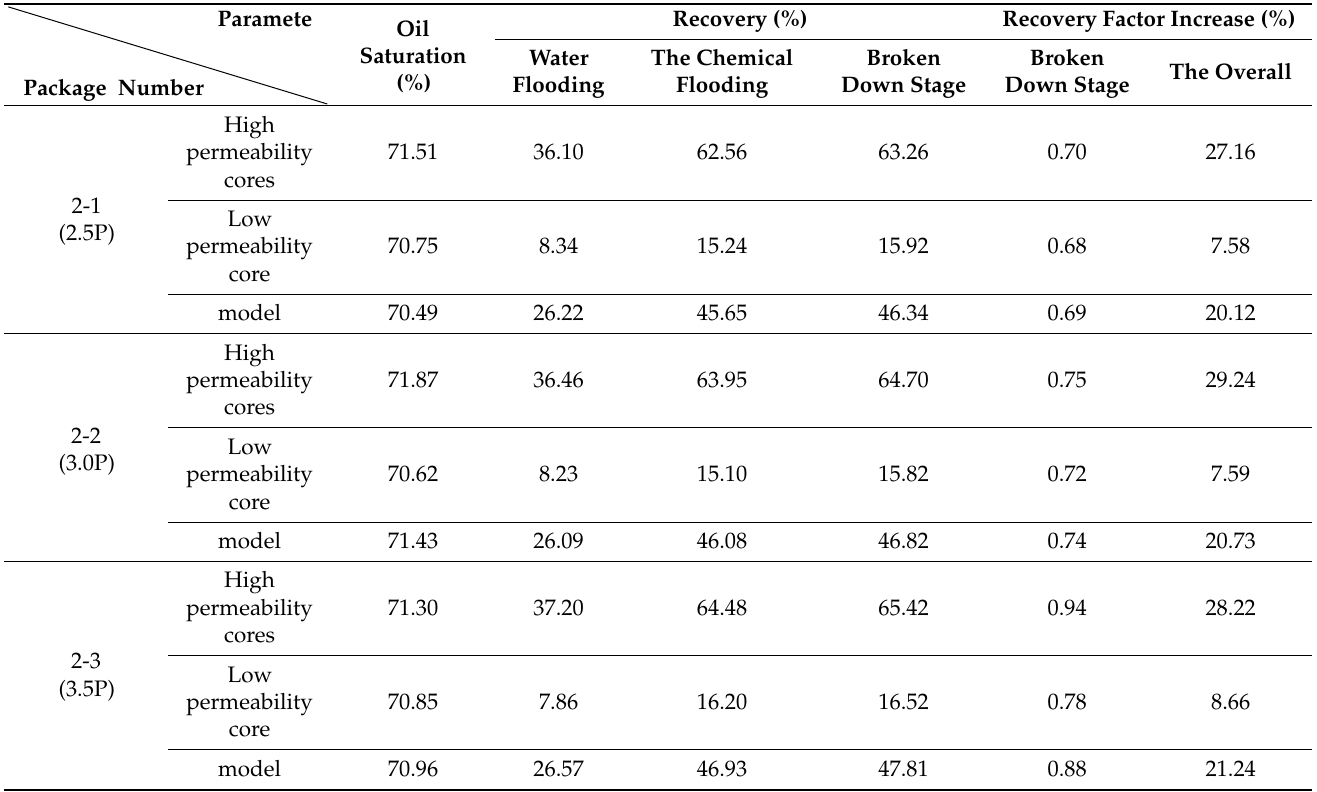
Table 2. Experimental data of recovery.